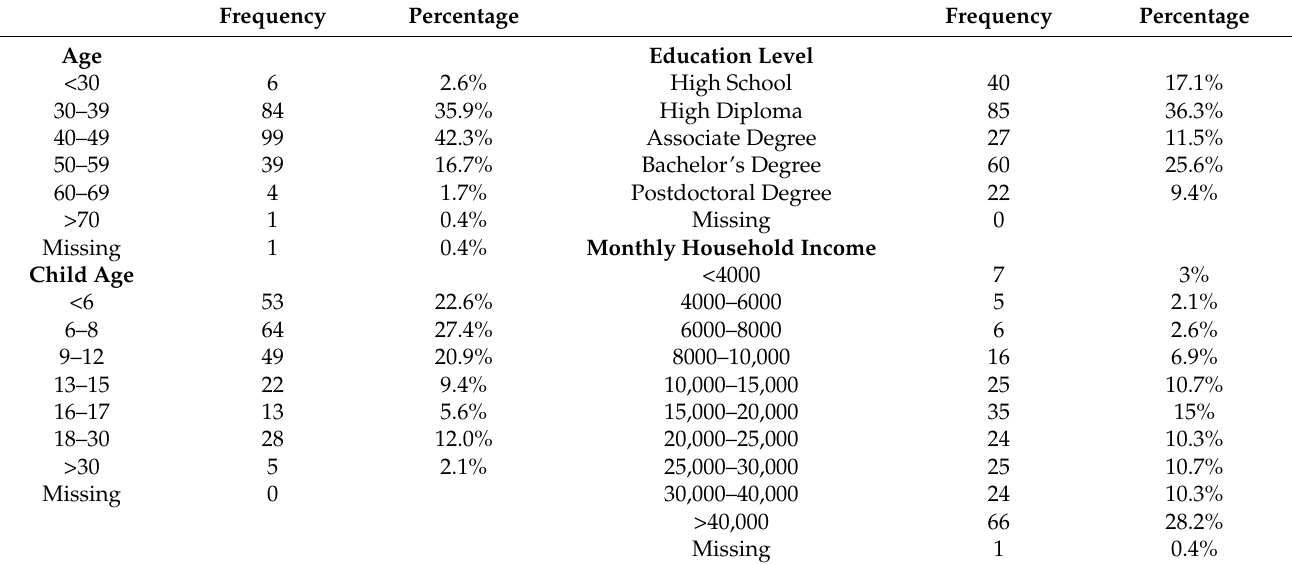
Table 1. Age, child age, household income level and education level of